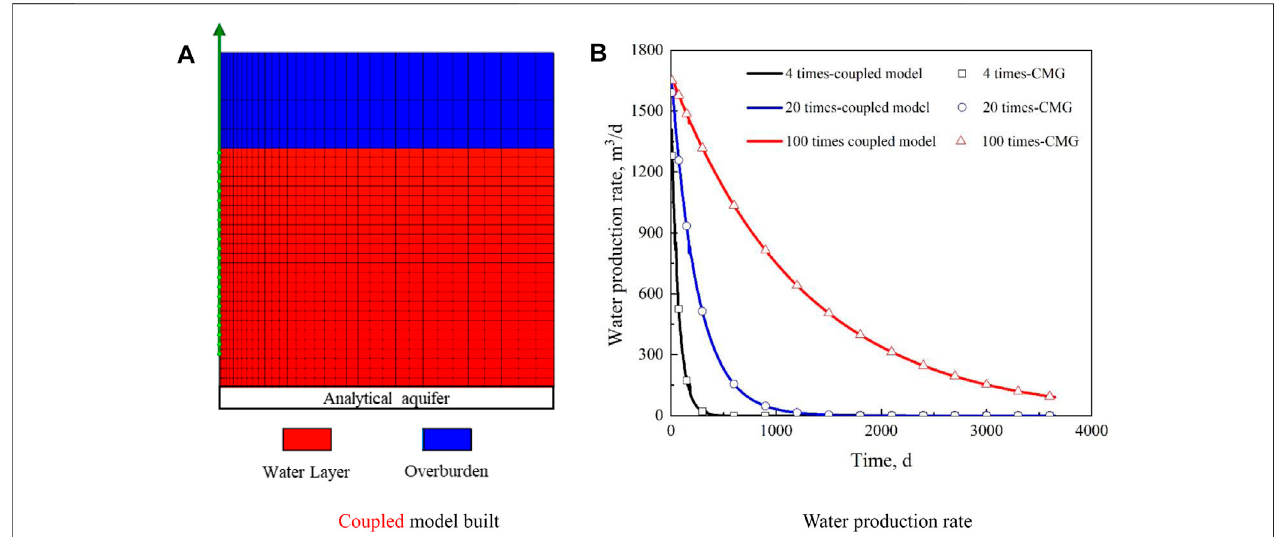
FIGURE 2 | The coupled model built and results used for validation. (A) Coupled model built. (B) Water production rate.